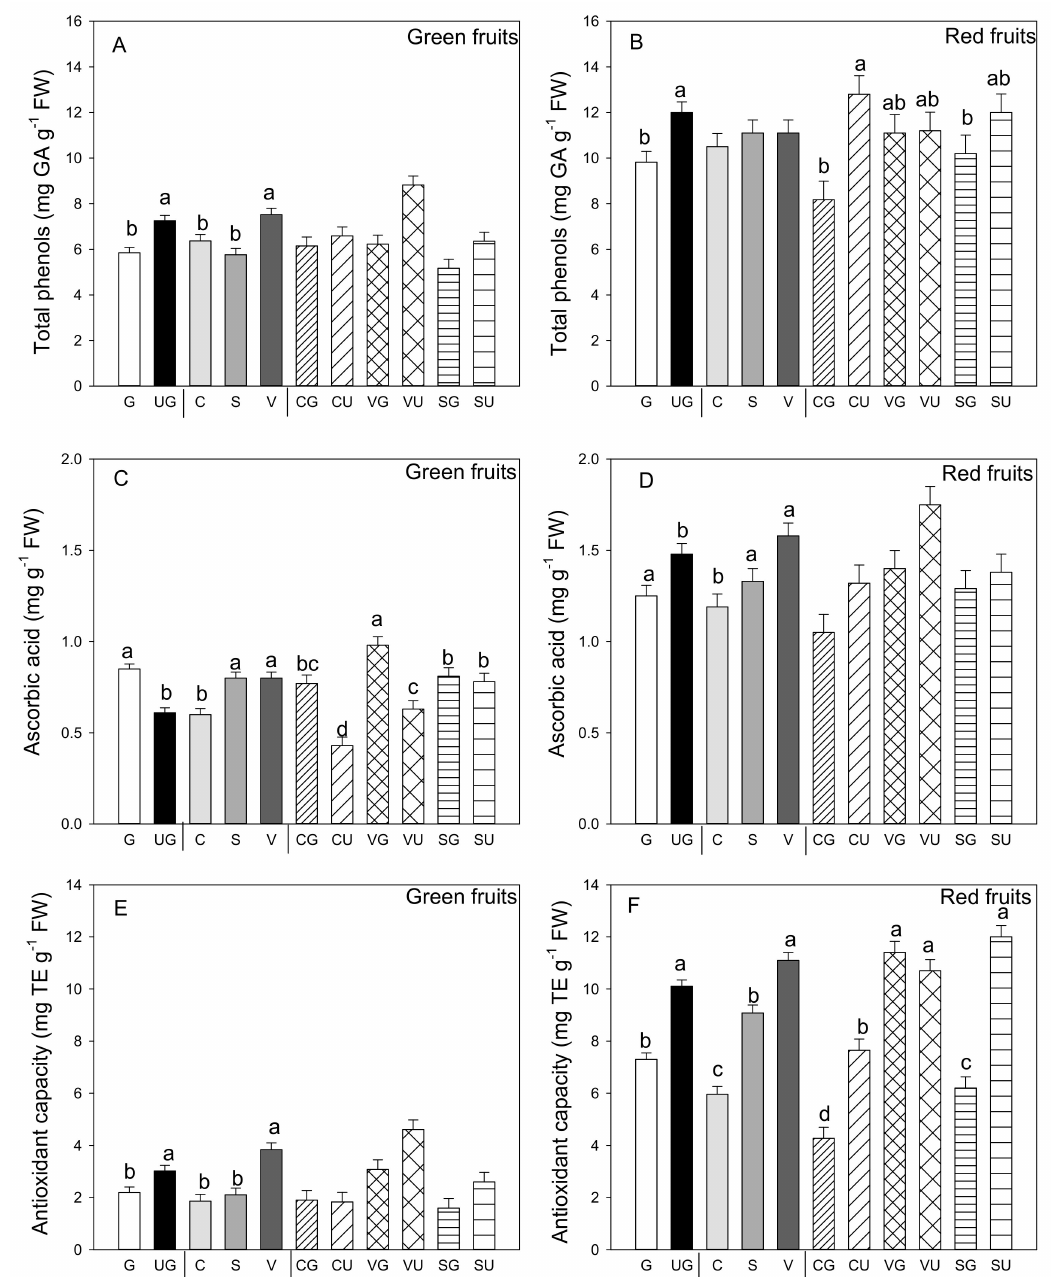
Figure 3. Total phenols ( A , B ), ascorbic acid amount ( C , D ) and antioxidant capacity ( E , F ) in the green ( A , C , E ) and red ( B , D , F ) fruit produced by the three pepper landraces “Cuerno” (C), “Valencia” (V), and “Sueca” (S) grafted (G) or ungrafted (U) on rootstock F1 NIBER ® . Values are the mean ± SE of three fruits per replicate (3 replicates) per landrace. Means were subjected to a two-way ANOVA with grafting and landrace as sources of variability. Di ff erent letters for factors grafting and landrace, or their interaction, indicate significant di ff erences at p < 0.05 using the LSD test. No letter indicates the non-significance of the F